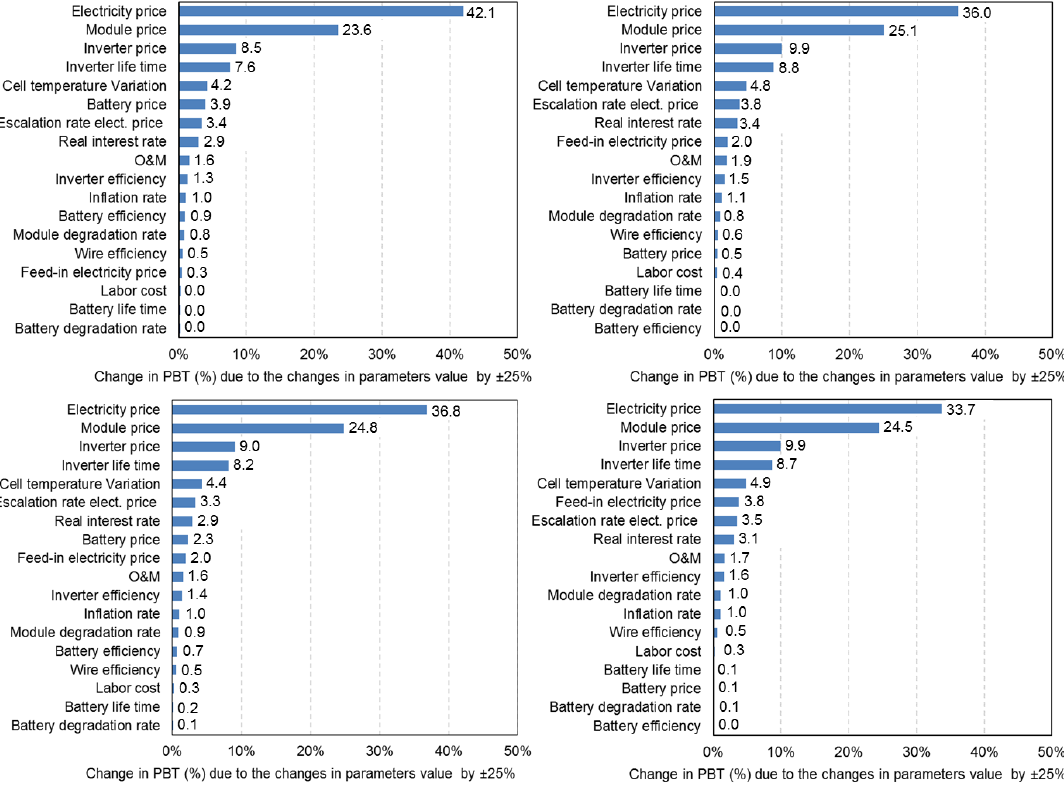
Figure 19. The impact of different factors in term of relative changes in the Payback time of the PV system for battery price 128 $/kWh (left) and 250 $/kWh (right). Feed-in tariff: 3.55 ₵ /kWh (top), and 6.7 ₵ /kWh (bottom). Annual saving target 75%.